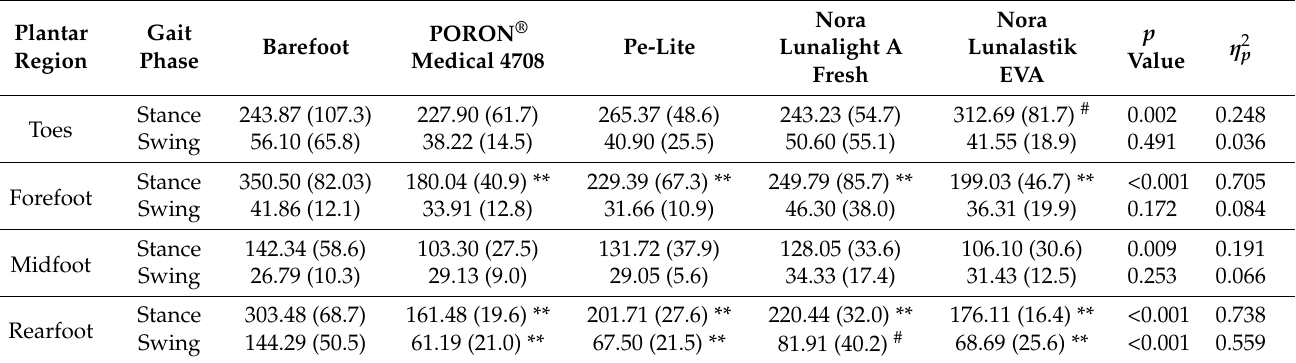
Figure 4. Mean of plantar pressure in four specific plantar regions for 5 conditions during gait. During the swing phase, the experimental insole material only significantly offloaded the PPP values in the rearfoot ( p < 0.001). Compared with the barefoot condition, the four insole materials significantly lowered the PPP values in the rearfoot (see Table 4). At the peak value point during the terminal swing phase, the PPP value with PORON ® Medical 4708 was the lowest in the rearfoot. Table 4. Statistical results for PPP with and without insoles (mean (SD); Unit: